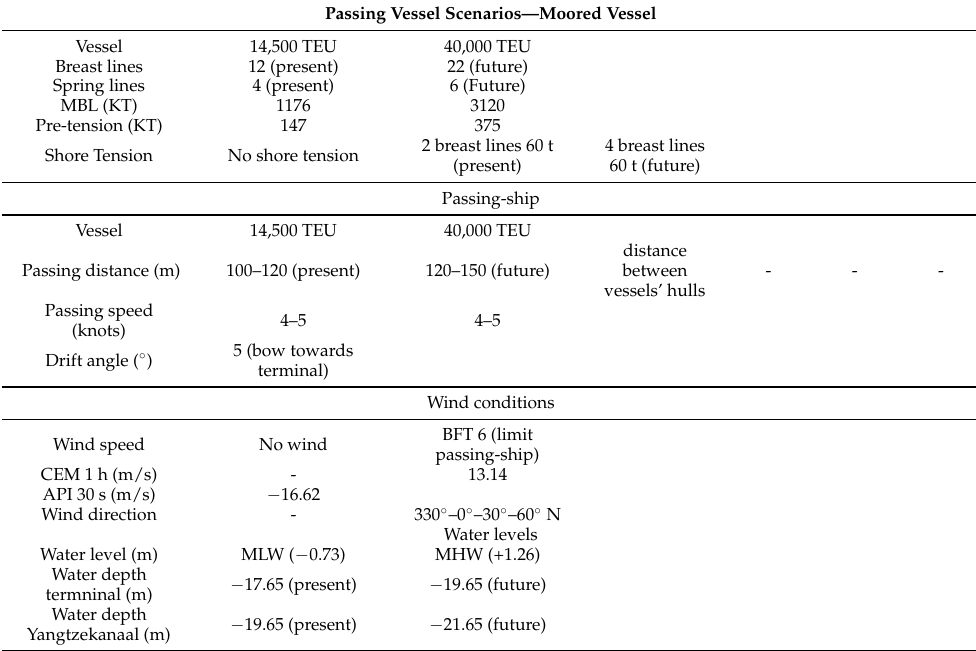
Table 4. Test program for passing-ship